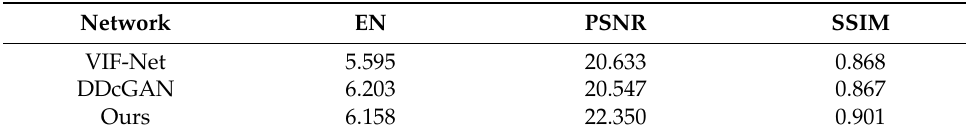
Figure 13. Experiment results of image fusion including four instances (each row). The first and second columns are the raw analog and digital PMMWIs, and the last three columns are the fusion images using three different methods. Table 2. Quantitative results of different fusion